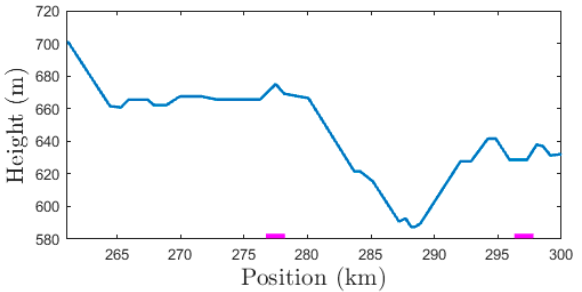
Figure 10. Height profile of the line section between Puertollano and Ciudad Real. Neutral zones are represented in magenta.